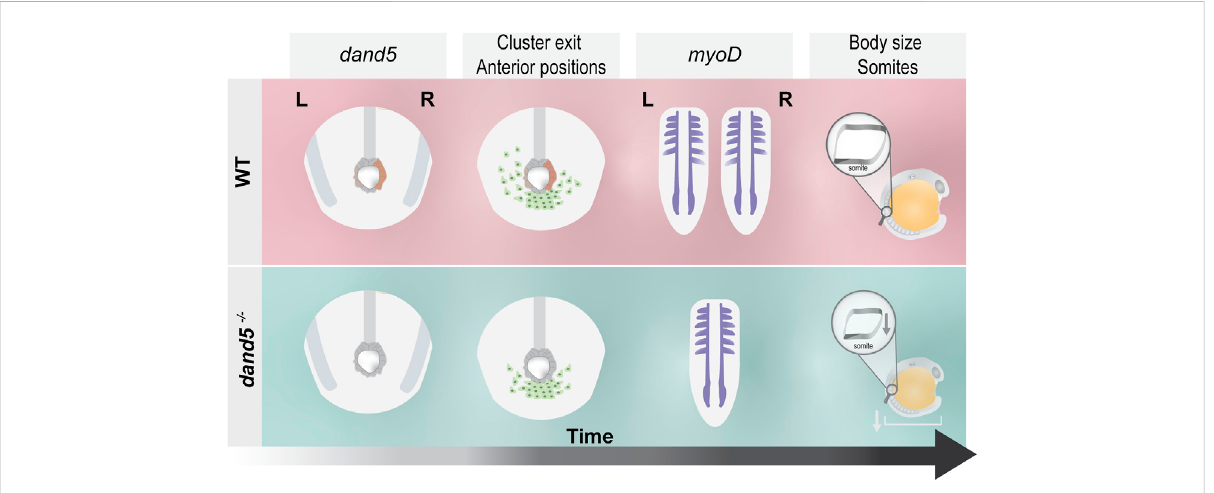
FIGURE 9 Schematic illustration of the main fi ndings of this study. In WT embryos, dand5 is expressed on the right side of the LRO, NKSTCs exit the posterior cluster fi rst from the left side in 50% of the embryos, and myoD is symmetrical in the same proportion of embryos. In dand5 − / − mutants, which lack dand5 expression, NKSTCs simultaneously depart from the posterior cluster from the left and right sides and acquire symmetrical positions. Later, myoD presumptive somite expression becomes symmetric, accordingly. In addition, in dand5 mutants, the width of the myoD segments was signi fi cantly shorter and the body length was